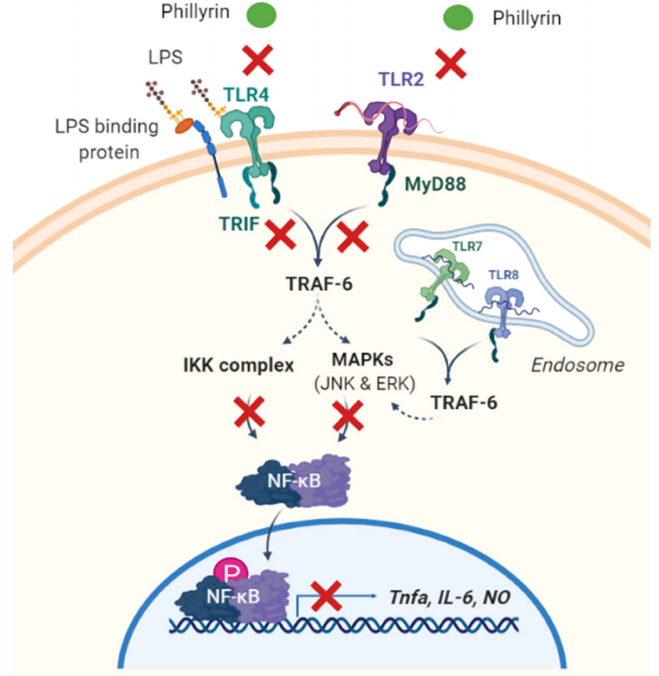
Figure 2. Graphic scheme of potential targets underlying phillyrin’s anti-inflammatory function. Phillyrin inhibits LPS-induced inflammation via the suppression of the TLR2 and TLR4 signaling pathways. Subsequently, in both MyD88-dependent and MyD88-independent manners, downstream NF- κ B and MAPK signaling is inhibited by phillyrin, so as the production of pro-inflammatory cytokines. IKK: IKappaB kinase, IL-6: interleukin-6, LPS: lipopolysacharide, MyD88: myeloid differentiation primary response 88, NF- κ B: the nuclear factor NF-kappaB, NO: nitric oxide, TLR: Toll-like receptor, TNF- α : tumor necrosis factor- α , TRAF6: TNF receptor-associated factor 6. (This figure was created with